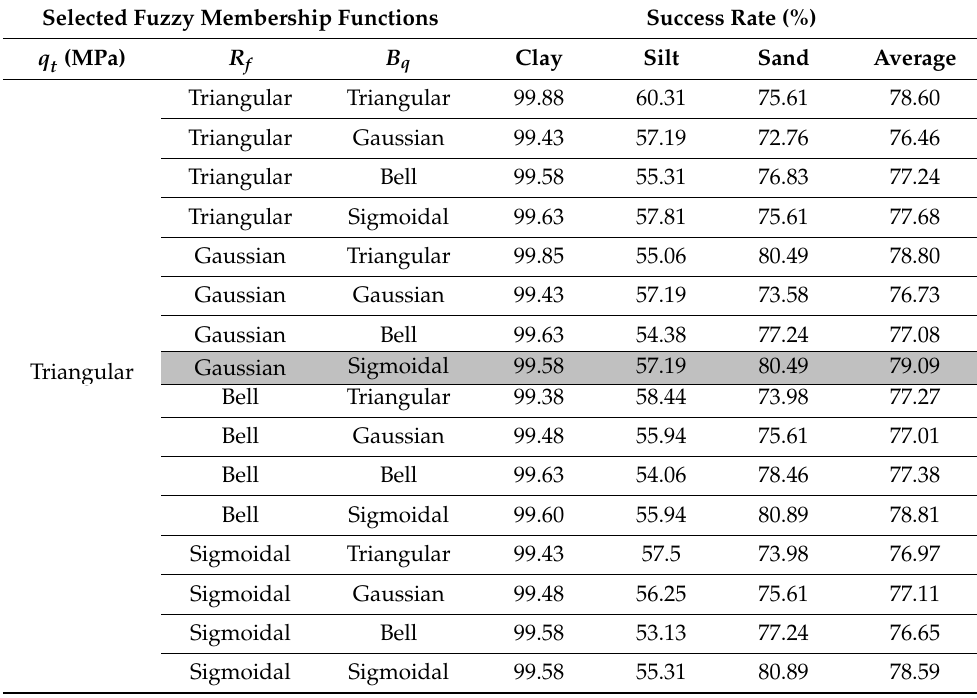
Table 4. Success rate when using a triangular membership function for q t .